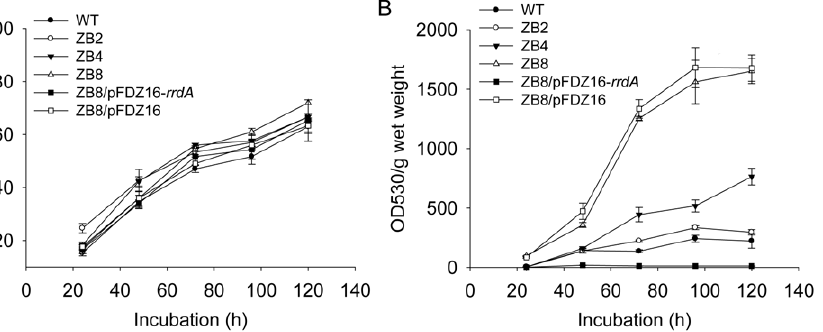
Figure 4. Growth curves and prodiginine production of wild-type strain, three mutant strains and complemented strains. Growth curves (A) and prodiginine production (B) of M145, ZB2, ZB4, ZB8, ZB8/pFDZ16 and ZB8/pFDZ16- rrdA growth in 40 ml of R4 liquid medium. Incubation was carried out at 30 u C. The symbols indicate the averages of three independent determinations and the error bars indicate the standard errors. OD 530 , optical density at 530 nm.